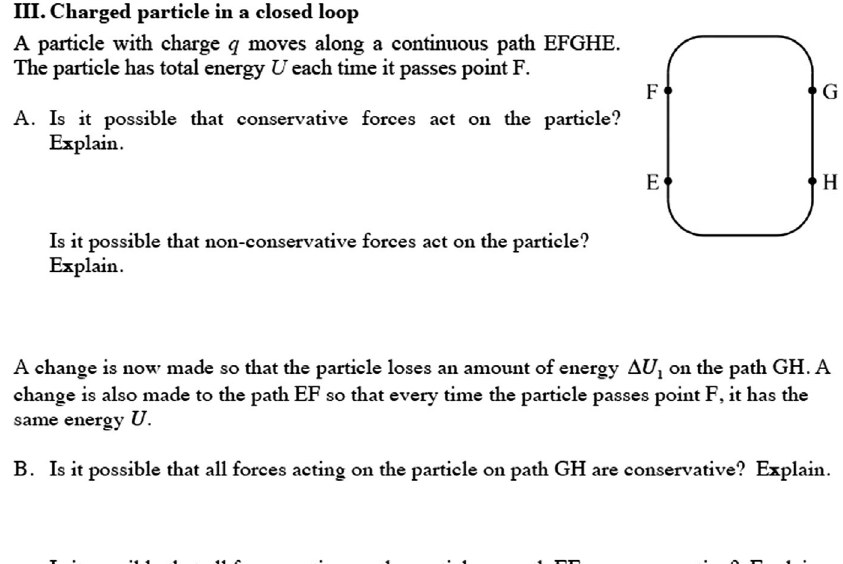
FIG. 1. Second activity of the first